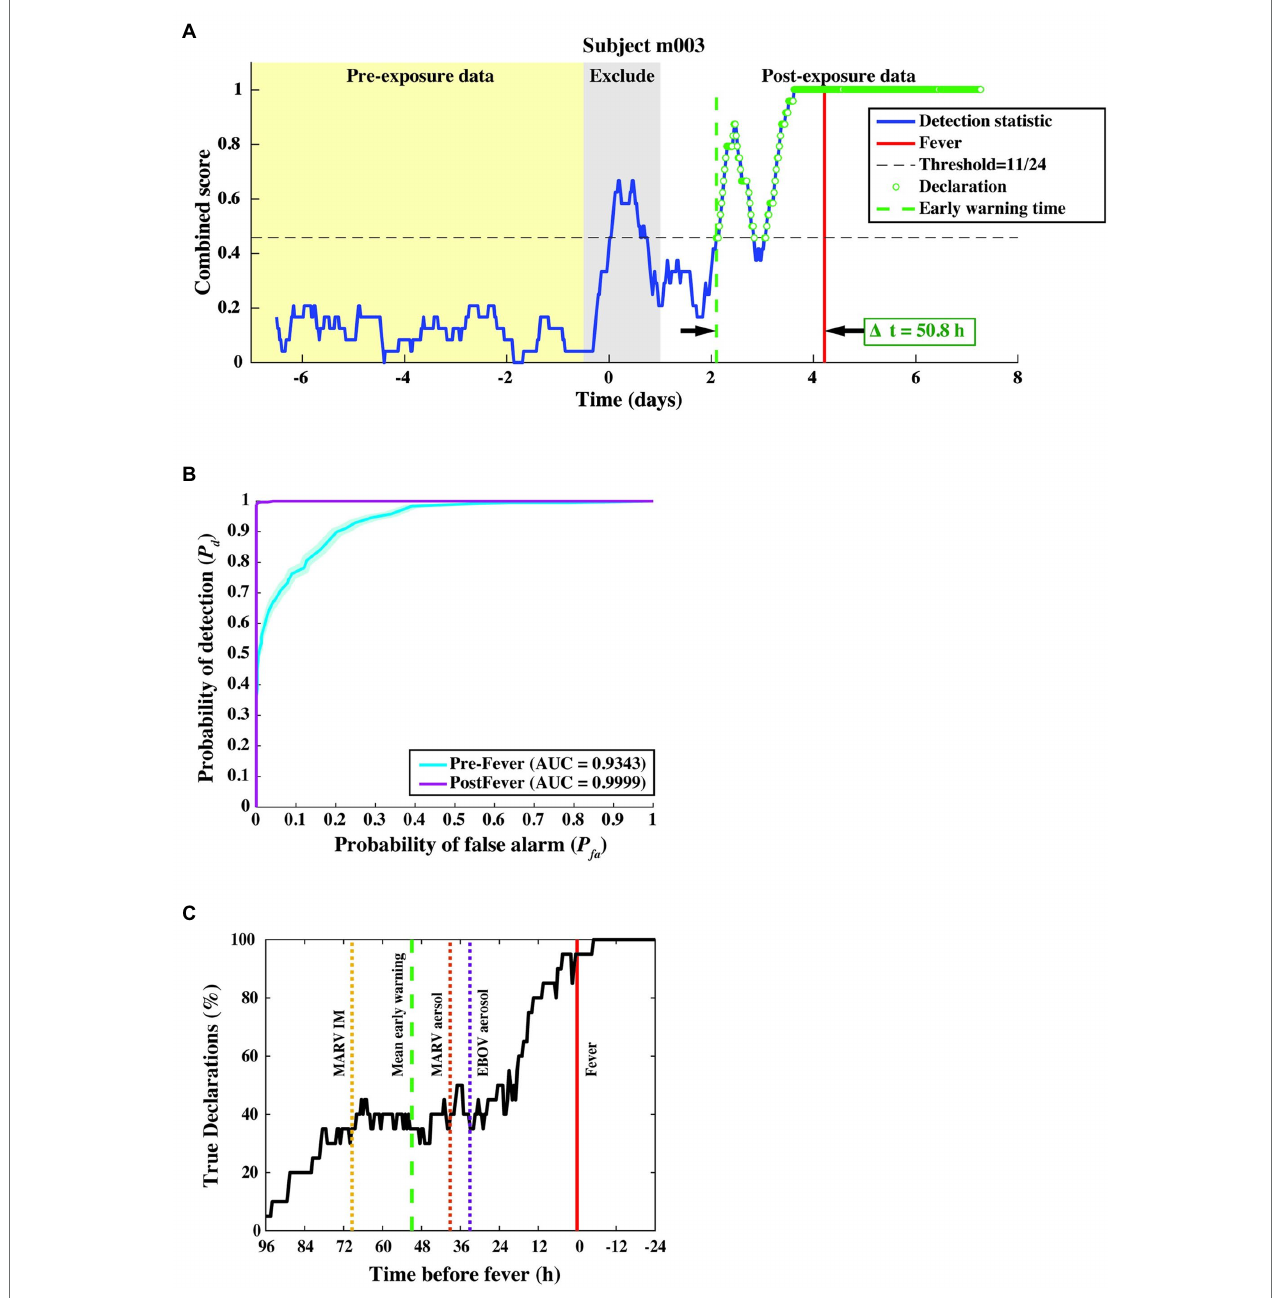
FIGURE 6 | Algorithm output and performance measures from the three-fold cross-validation. (A) The combined score (blue curve) vs. time for a subject from the MARV aerosol exposure study, where samples declared as “exposed” are shown as green circles. The red vertical line indicates the fever onset time, and the green dashed vertical line denotes the first true positive declaration. The early warning time Δ t is the interval between the green and red vertical lines. (B) ROC curve across 20 subjects, indicating nearly perfect performance after febrile symptoms and strong positive predictive power (AUC = 0.93 ± 0.01) before fever. (C) P d vs. time before fever. The mean Δ t for each of the three constituent studies is indicated by the dashed line. We find that half of the subjects are correctly identified as exposed at least 24–36 h before fever, regardless of the particular pathogen, exposure route, or target